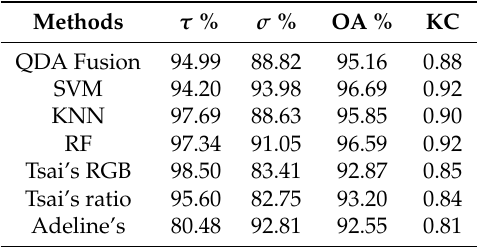
Table 2. Comparative results for shadow detection in